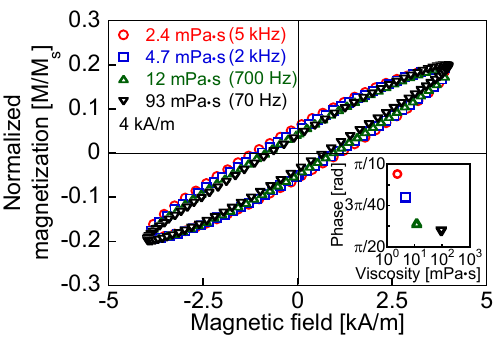
Figure 4. Measured AC hysteresis loops for viscosities of 2.4, 4.7, 12, and 93 mPa ∙ s at frequencies close to the relaxation peaks shown in Table 1. The insets show the viscosity dependence of the phase delay derived from the coercivities of the AC hysteresis loops.